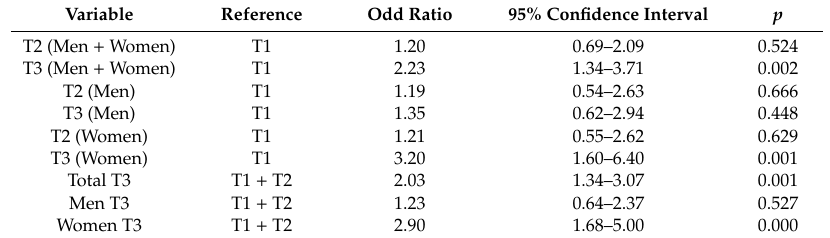
Table 2. Odds ratios of each tertile for silent infarction / white matter change (SI / WMC) on brain CT.